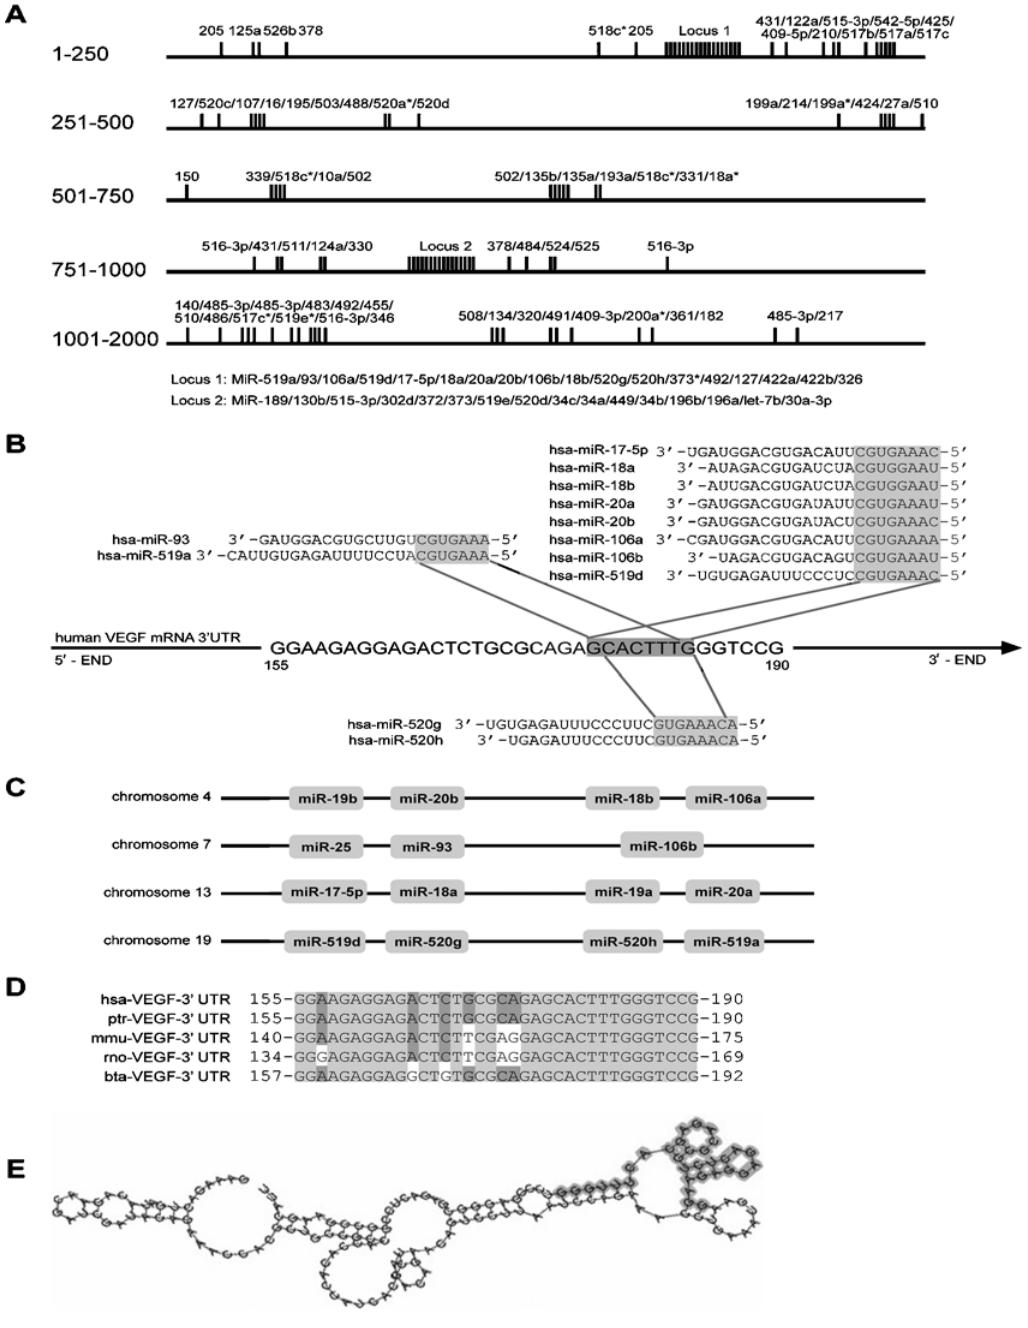
Figure 1. Analysis of miRNA binding sites in VEGF. (A) The map of miRNA binding sites in the VEGF 3 9 -UTR in accordance with Table S1. Three bioinformatics algorithms, RNAhybrid, miRanda, and FindTar, were used to predict miRNA binding sites in the VEGF 3 9 -UTR. A binding site map of the VEGF 3 9 -UTR was generated with the putative binding sites predicted by at least two bioinformatics algorithms. Subsequently, two miRNA binding site-condense regions (MBSCR) were uncovered, that is, 160–195nt and 820–860nt MBSCR. (B) A common miRNA binding site located in 160–185nt shared by 12 miRNAs. (C) The miRNAs that share this common miRNA binding site belong to four different miRNA clusters. (D) The seed region of this common miRNA binding site is highly conserved among mammals. (E) RNAcofold was used to analyze the secondary structure of the common miRNA binding site and its flank regions in the VEGF 3 9 -UTR. The common binding site is located in an unstable region with a multi-branching loop- like RNA structure.